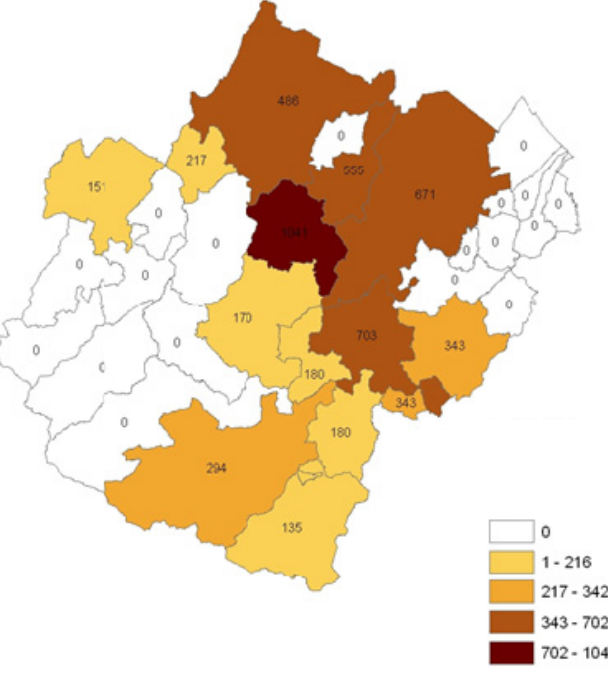
Figure 4. Map of the model results for the single parcel plants (the power of each plant is shown in kWe).